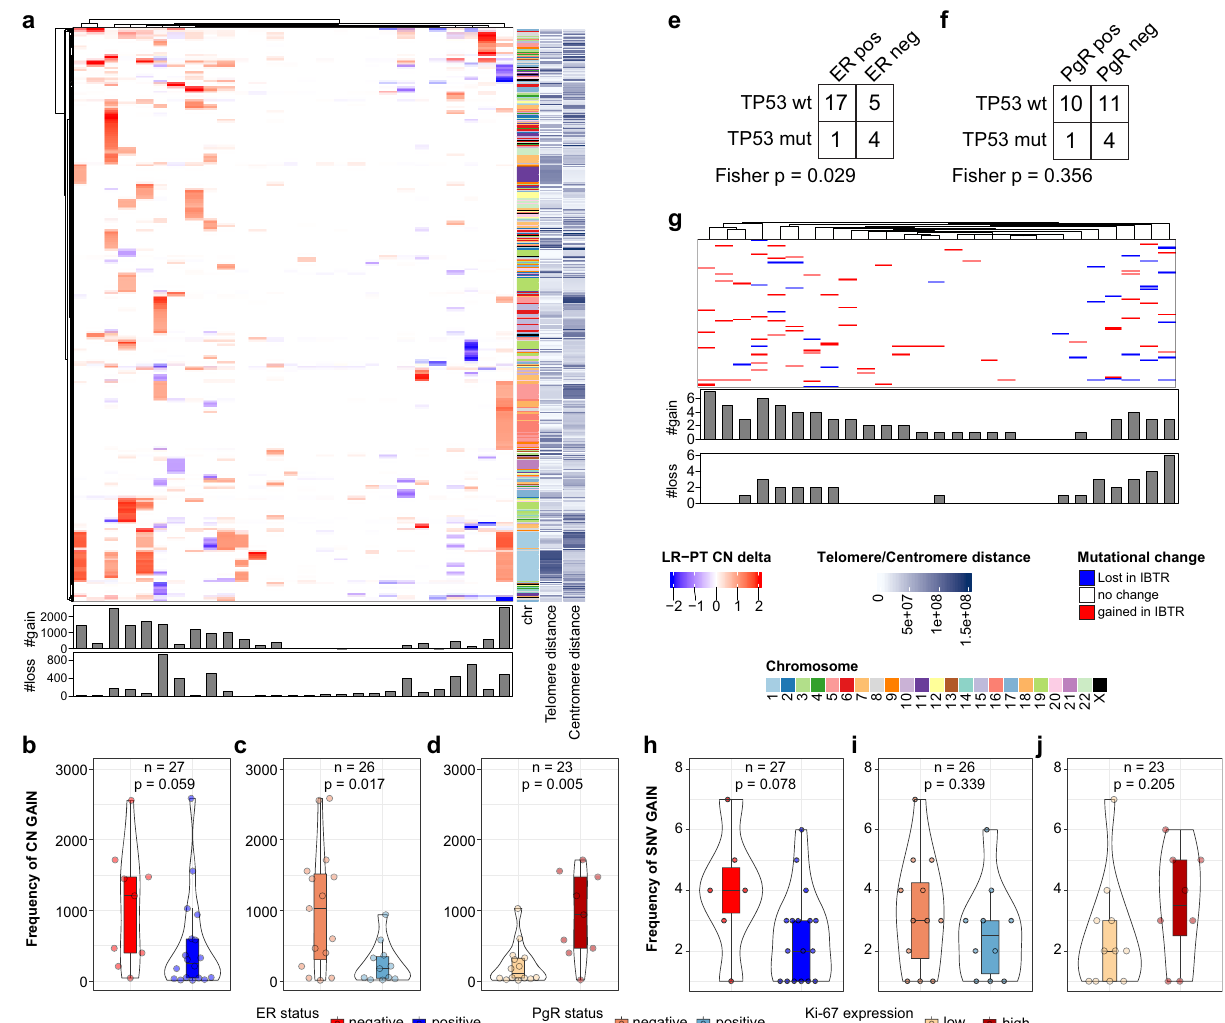
Fig. 3 Changes in copy number and key drivers. CN changes between paired tumors and mutational (SNV) status of COSMIC cancer genes was evaluated in our cohort. a Heatmap of copy number changes between primary and recurrent tumors. Bottom bar charts display sample-wise frequencies of IBTR CN gain and loss over the matched PT. b – d Association of CN gain between primary and recurrent tumors to key biomarkers. e , f Displays contingency analyses between hormonal receptor (ER and PgR) status and TP53 mutations at the PT level. g Association of SNV status change (i.e., gain or loss in IBTR) of cancer genes from COSMIC. h – j Association of SNV gain between primary and recurrent tumors to key biomarkers. Light gray boxes in heatmaps represent missing values. Number of samples included in each test depends on availability of clinical data. Boxplots depict distribution of values as quartiles. Line at the center of each boxplot depict the median value. Bar charts below each heatmap represent sample-wise counts for CN or SNV gains and losses. CN copy number, ER estrogen receptor, Ki-67 antigen Ki-67, IBTR ipsilateral breast tumor recurrence, IBTRFS IBTR-free survival, PgR progesterone receptor, PT primary tumor, SNV single nucleotide variant, TP53 , tumor protein